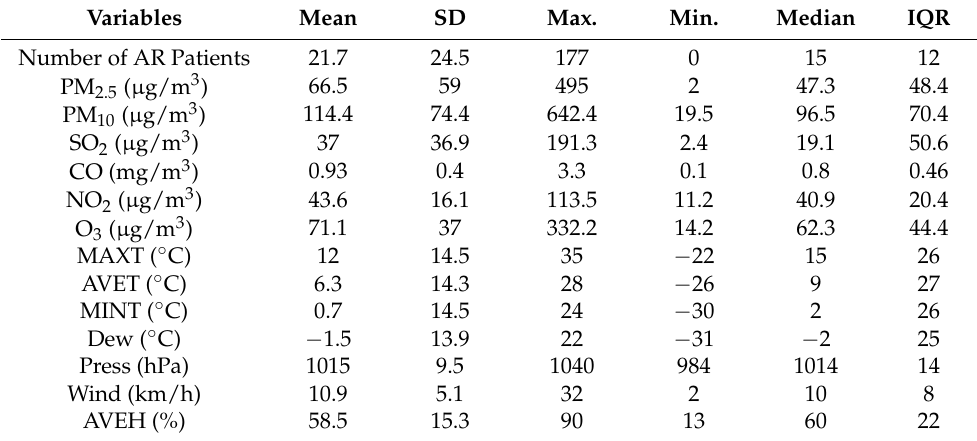
Summary of environmental variables and daily number of outpatients for AR in Changchun,